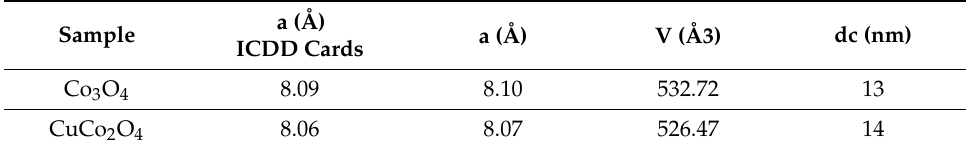
Table 1. Cell parameters and crystallite size of the as-prepared oxide nanoparticles calculated from diffraction patterns.